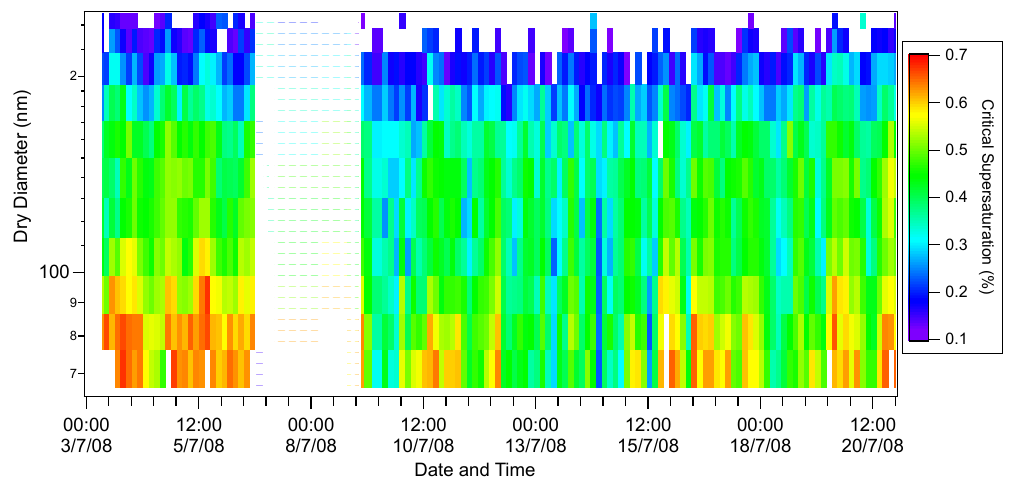
Fig. 4. The derived critical supersaturation for OP3-III as a function of dry diameter.